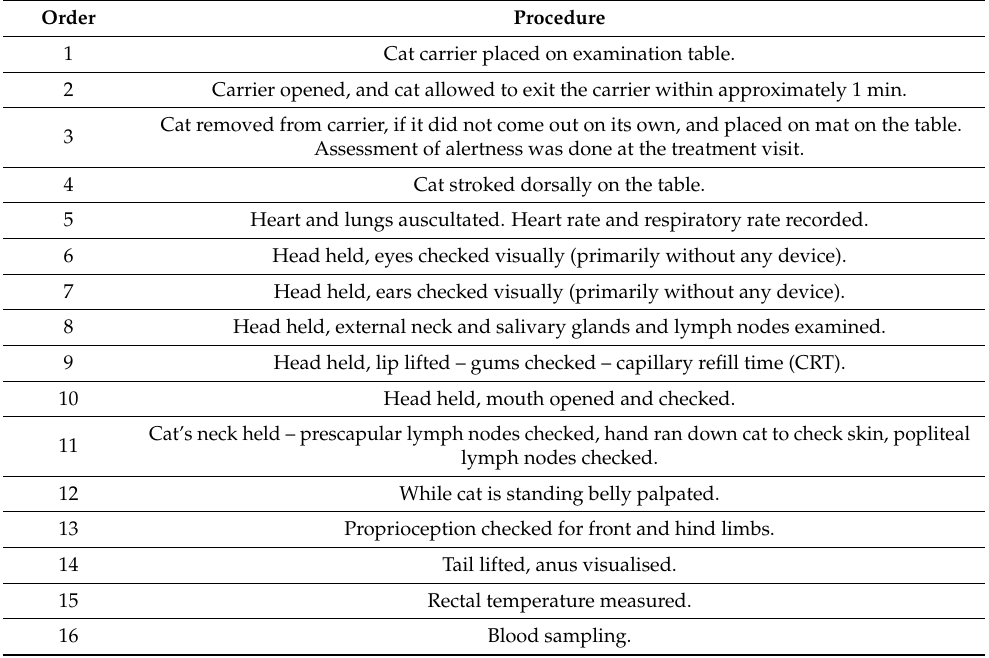
Table 3. Standardized clinical examination performed by the investigator at the veterinary clinic with specified order of performance in increasing invasiveness.